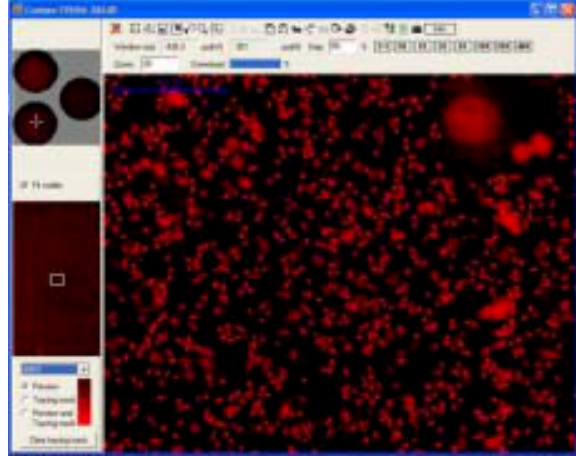
Overview of high throughput fluorescence DNA image Conclusion: Advantages of DNA-FCM and